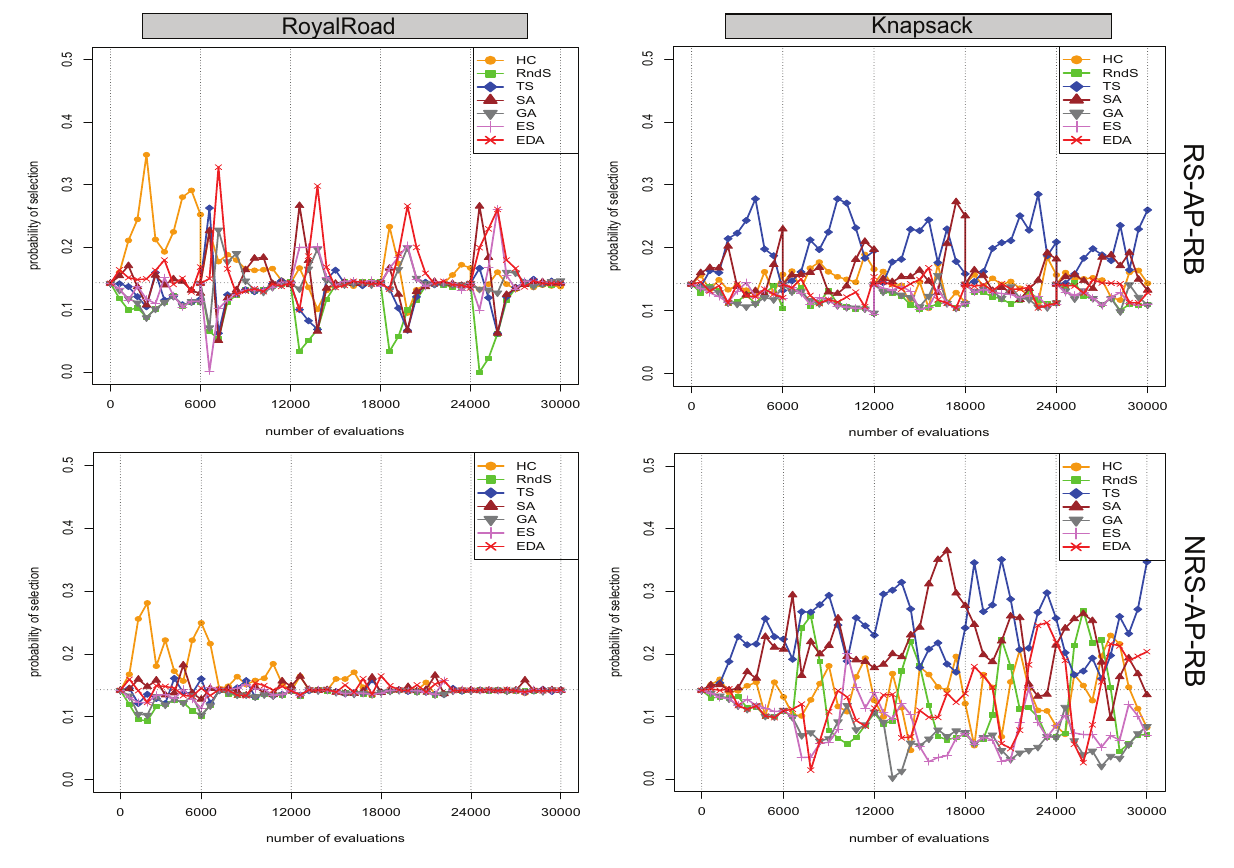
Fig. 4. Evolution of the mean selection probability for each individual algorithm, measured every 600 evaluations and aggregated over 30 runs, in the first five changes of the objective function. Rows and columns corresponds to learning schemes (RS-AP-RB and NRS-AP-RB) and prob- lem configurations ([RoyalRoad (severity 0.5, frequency of change 6000) and Knapsack (severity 0.5, frequency of change 6000)), respectively. In each plot, the horizontal line marks the probability value for a uniform distribution where all individual algorithms have the same selection probabil- ity, whereas the vertical lines show when the changes take